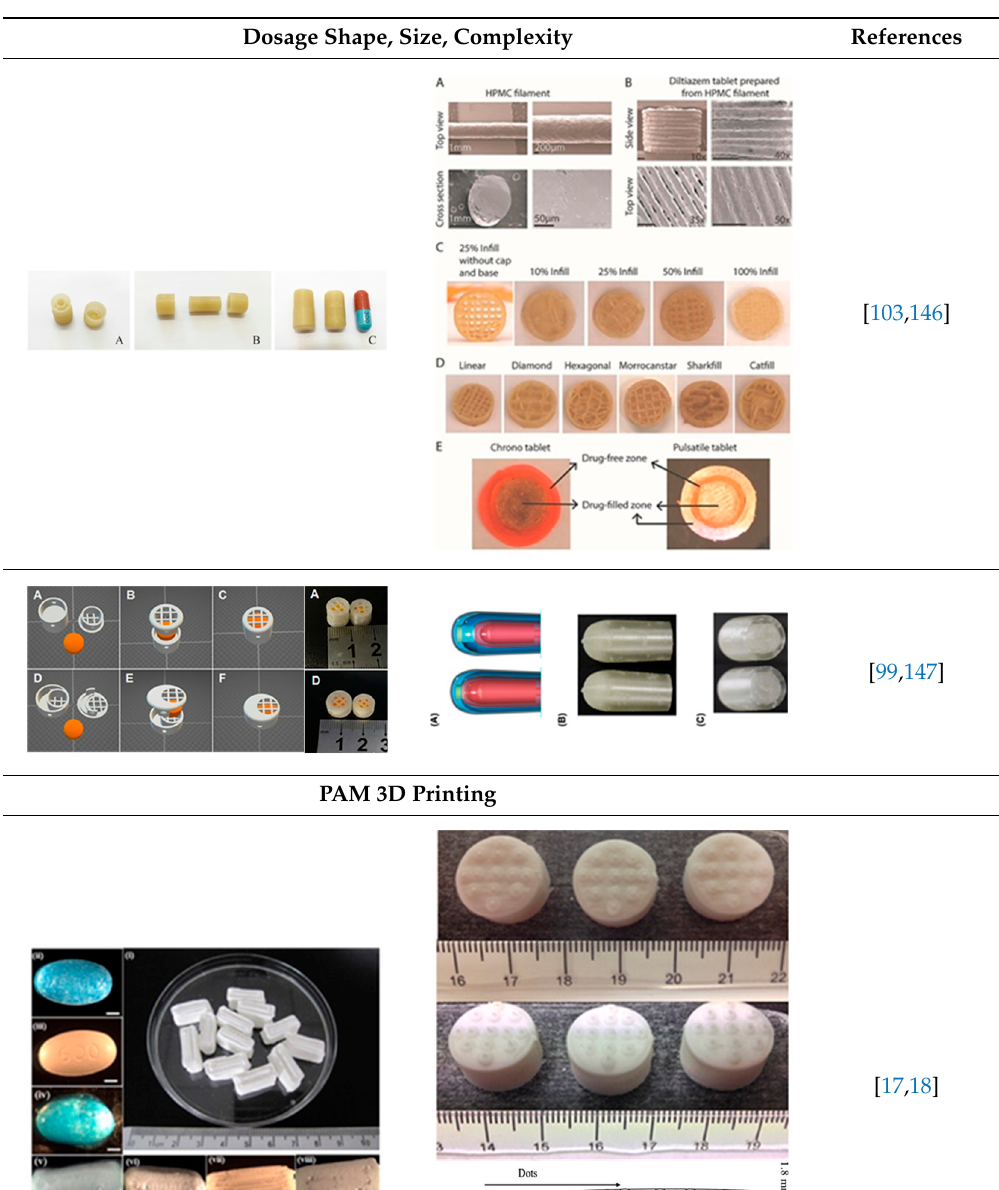
Table 4. Cont. Dosage Shape, Size,